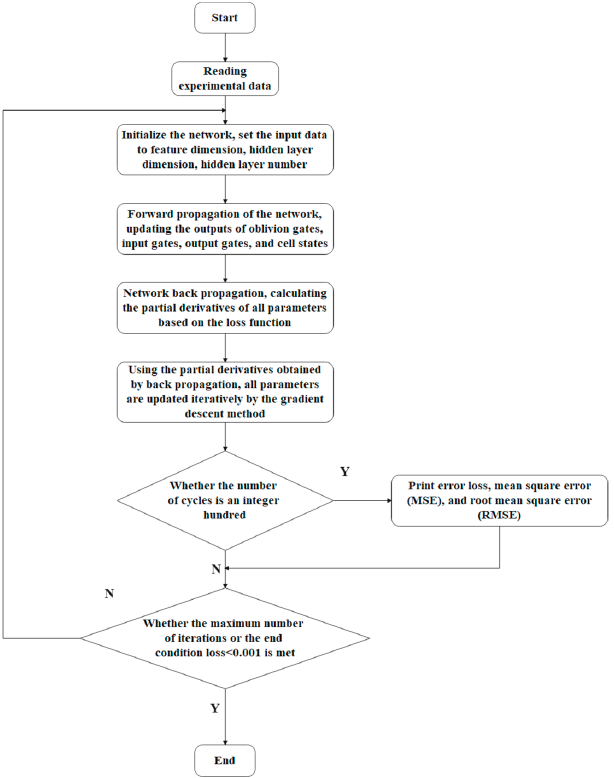
Figure 8. Model training framework.